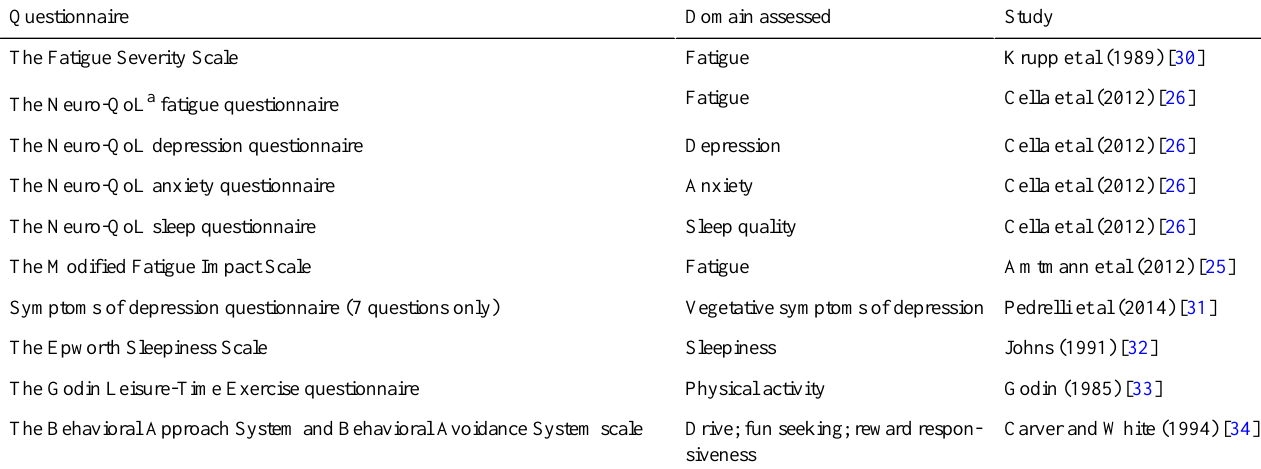
Table 2. Summary of existing questionnaires incorporated into our one-time questionnaire